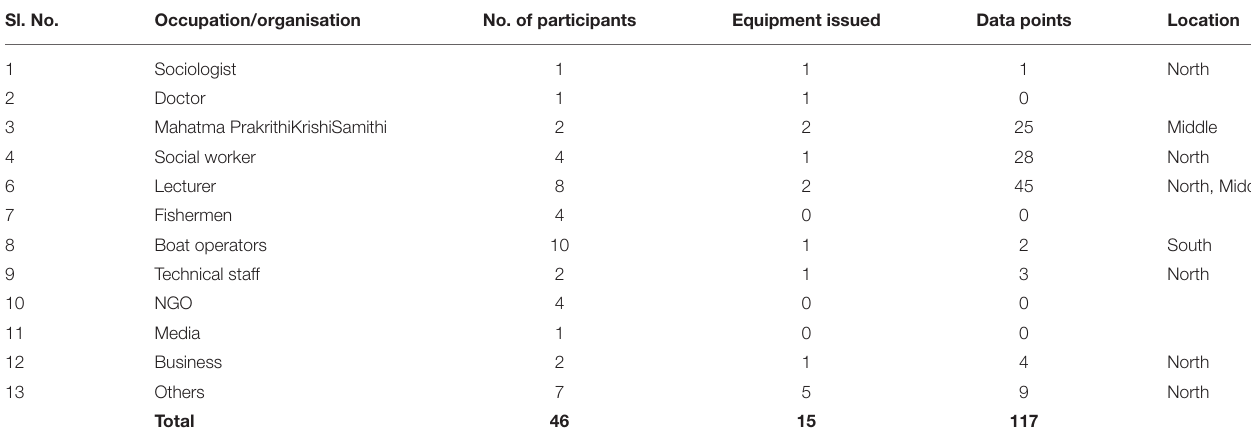
TABLE 2 | Activity summary of the stakeholders other than students. Sl.